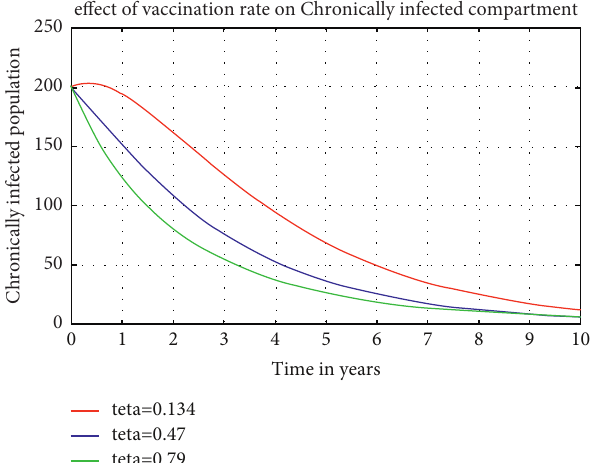
Figure 14: Effect of vaccination rate on chronically infected compartment.